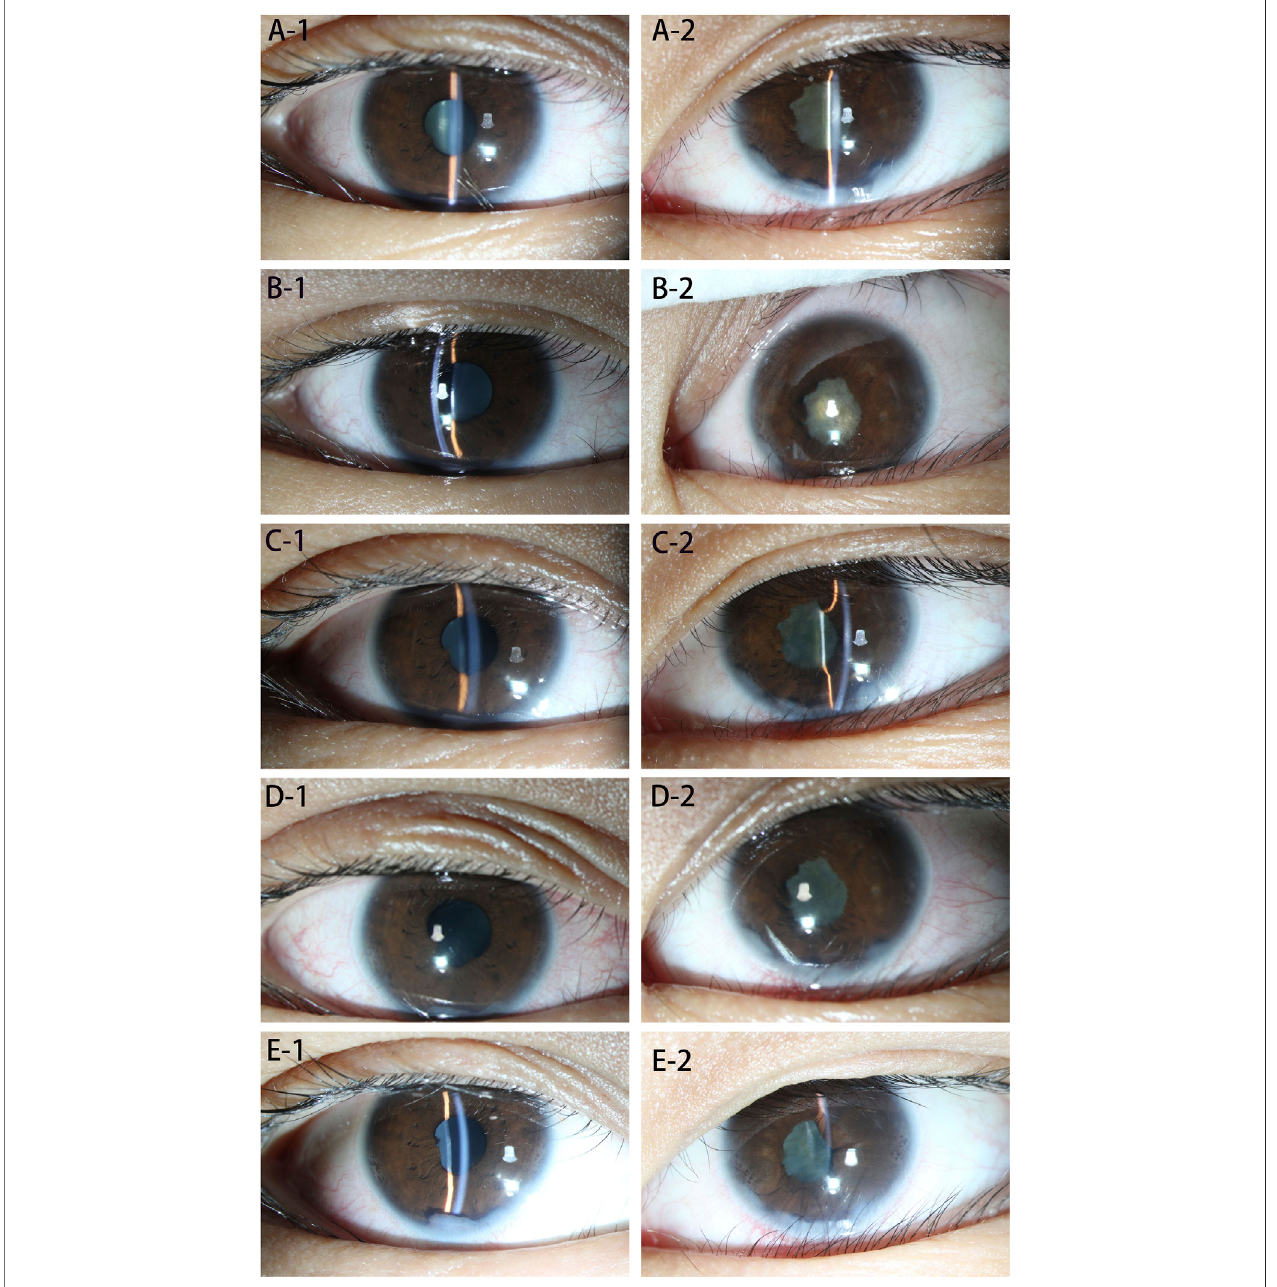
FIGURE 2 | (A – E) : Eye examination at each stage. (A-1) Shows the right eye before treatment, showing mild mixed conjunctival hyperemia, anterior chamber empyema, posterior corneal deposits (+), posterior iris adhesions, and mild lens opacity. (A-2) Shows the left eye before treatment, showing mild mixed conjunctival hyperemia, anterior chamber empyema, posterior corneal deposits (+), posterior iris adhesion and pupil closure. (B-1) Shows the right eye 1 month after the treatment. Conjunctivalhyperemia,anteriorchamberempyema,posteriorcornealdeposits(+),andposterioririsadhesionsdidnotchangesigni fi cantly,andthedegreeoflens opacitywaslessthanbefore. (B-2) Showsthelefteye1 month aftertreatment;therewasnoobviouschangecompared withthepreviouspicture. (C-1) Showstheright eye 2 months after treatment; there was no signi fi cant change compared with the previous picture. (C-2) Shows the left eye 2 months after treatment, with mild mixed conjunctival hyperemia, anterior chamber empyema, posterior corneal deposits (+), posterior iris adhesions compared to before, no obvious changes, and fi ber exudation in the pupil area. The fi lm was absorbed and became lighter than before. (D-1) Shows the right eye, 3 months after treatment. The patient ’ s conjunctival hyperemiawasworsethan before, and theresthad noobviouschanges. (D-2) Showstheleft eye3 months after treatment, theconjunctivalhyperemia wasworsethan before, and the rest showed no obvious changes. (E-1) Shows the right eye, 10 months after treatment. Conjunctival mixed congestion is lessened, anterior chamber empyema, posterior corneal deposits, and the front image showed no obvious changes; the posterior iris adhesions were loosened compared with the front, the lens surfacewaspigmented,andthelenswasslightlyopaque. (E-2) Showsthelefteye,10 monthsaftertreatment.Conjunctivalmixedconjunctivalhyperemiawaslessened, posterior iris adhesions were aggravated, and the rest had no obvious